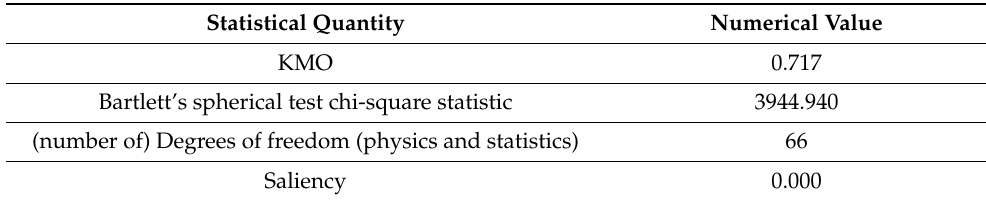
Table 5. KMO measurement and Bartlett